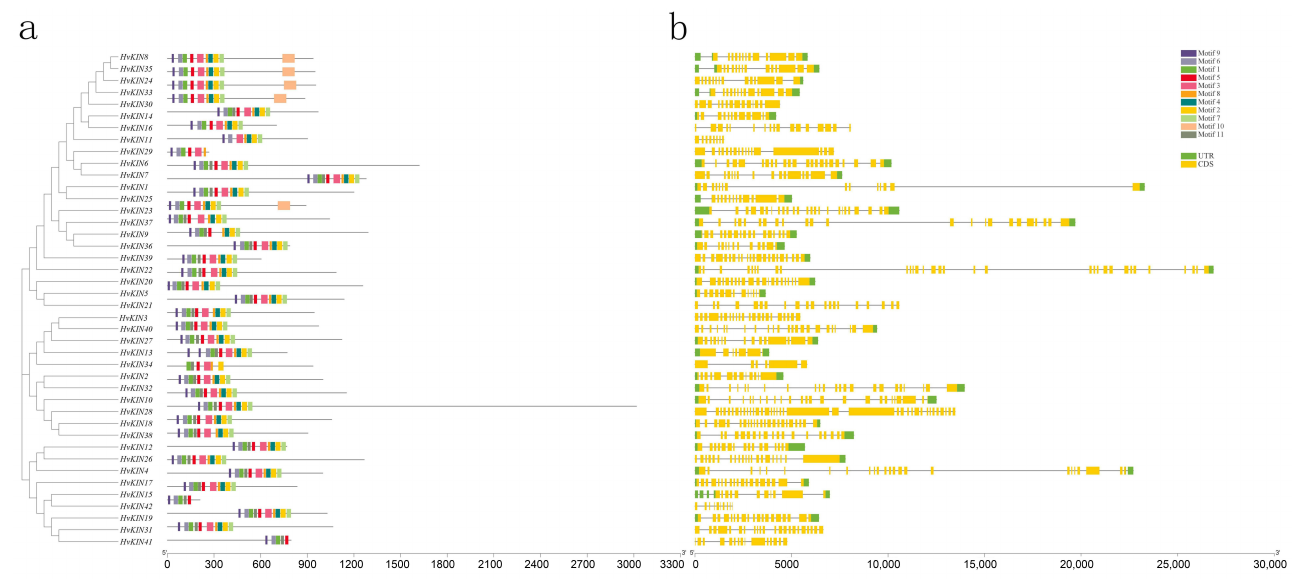
Figure 4. HvKINs structure and conserved motif distribution analysis. ( a ). The barley HvKIN proteins’ motif composition. The motifs, which are shown in variously colored boxes, were identified by MEME 5.0.1 in the HvKIN proteins. ( b ) The yellow and green bars represent the CDS and the untranslated region (UTR), respectively, while the black line represents the